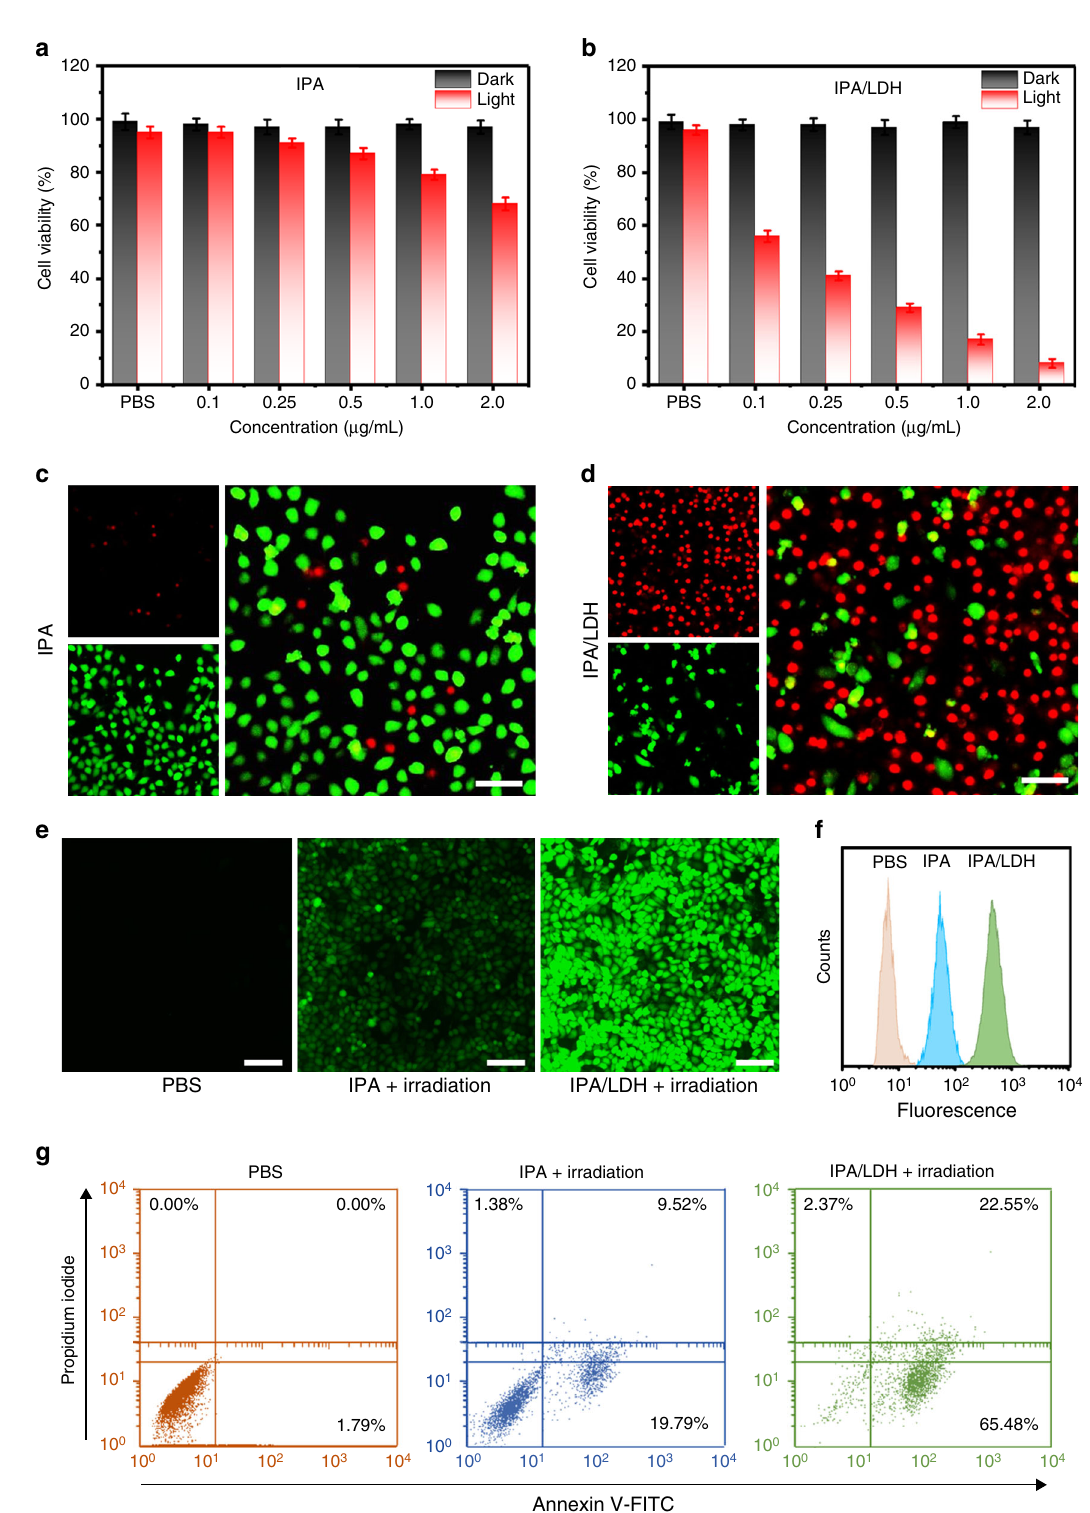
Fig. 4 In vitro PDT effects of IPA/LDH with Hela cells. MTT assay of cell viabilities with and without irradiation following incubation with a IPA and b IPA/ LDH, respectively. The corresponding Calcein-AM/PI staining images of cells treated with c IPA and d IPA/LDH following irradiation. Scale bar = 50 nm. e Intracellular ROS production treated with different samples using DCFH-DA as a probe. Scale bar = 100 nm. f Flow cytometry measurements of DCFH-DA signal for PBS (pink), IPA (blue), and IPA/LDH (green). g Flow cytometry measurement results of Annexin V-FITC/PI double stained cells treated with PBS, IPA, and IPA/LDH followed by laser irradiation. Error bars were de fi ned as standard deviation, n =